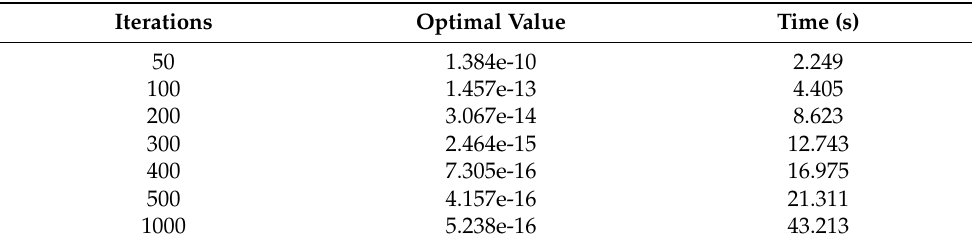
Table 13. The relationship between the iterations and the optimal value of the objective function calculated by the OMO